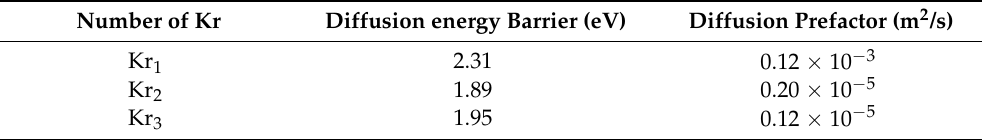
Table 2. Diffusion energy barrier and diffusion prefactor of small interstitial Kr clusters in UO 2 . Number of Kr